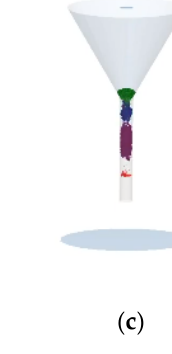
Figure 8. Schematic diagram of discrete element repose simulation flow.